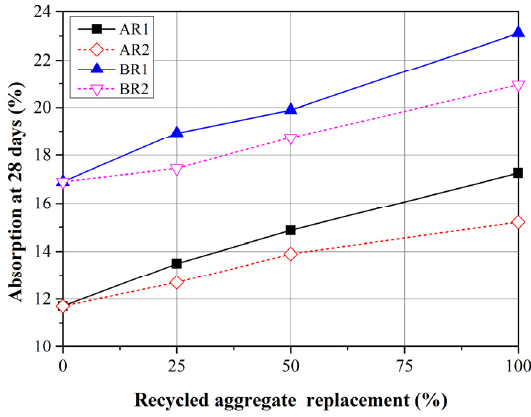
Figure 7. Absorption of mortars with R1 and R2 replacement at 28 days.